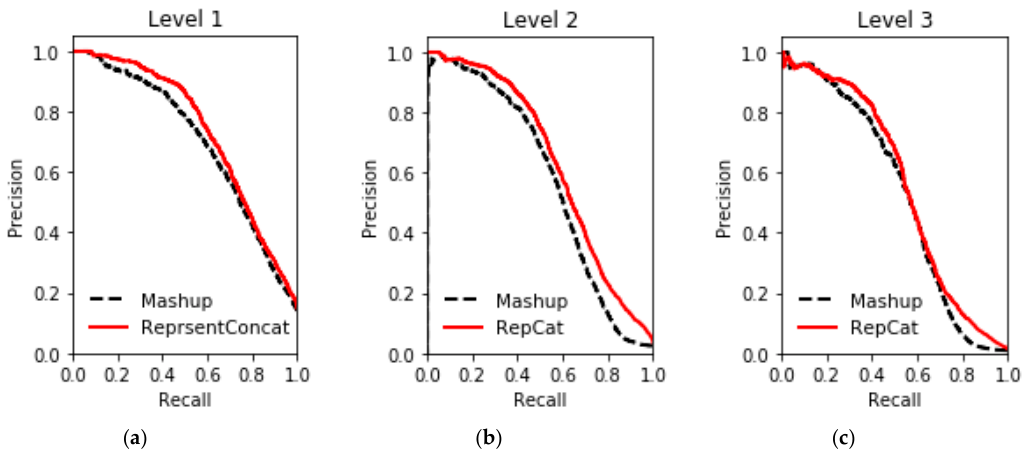
Figure 3. Comparison of performance on yeast datasets between ReprsentConcat and Mashup: ( a ) Level 1; ( b ) Level 2; and ( c ) Level 3.